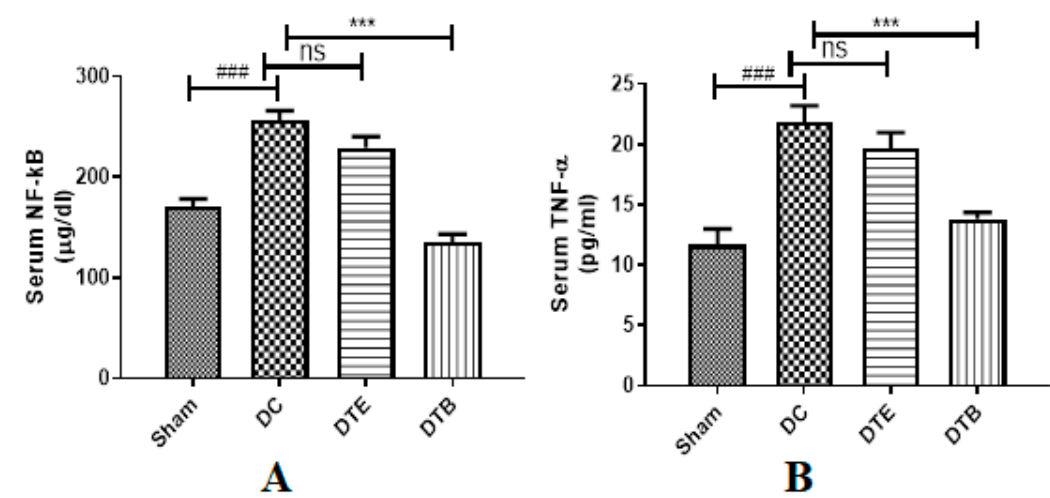
Figure 3. Effect of AKBA on serum inflammatory markers in ovariectomized rats. ( A ) Serum NF- κ B and ( B ) Serum TNF- α . Data represented as mean ± SEM ( n = 6) examined by one way ANOVA followed by Tukey’s multiple comparison test. ### Statistically significant ( p < 0.001) from sham control group. *** Statistically significant ( p < 0.001) from disease control (DC) group. DTE: ovariectomized animals treated with estradiol (0.05 mg / kg); DTB: ovariectomized animals treated with AKBA (35 mg / kg). AKBA: acetyl-11-keto- β -boswellic acid; ns: non-significant.